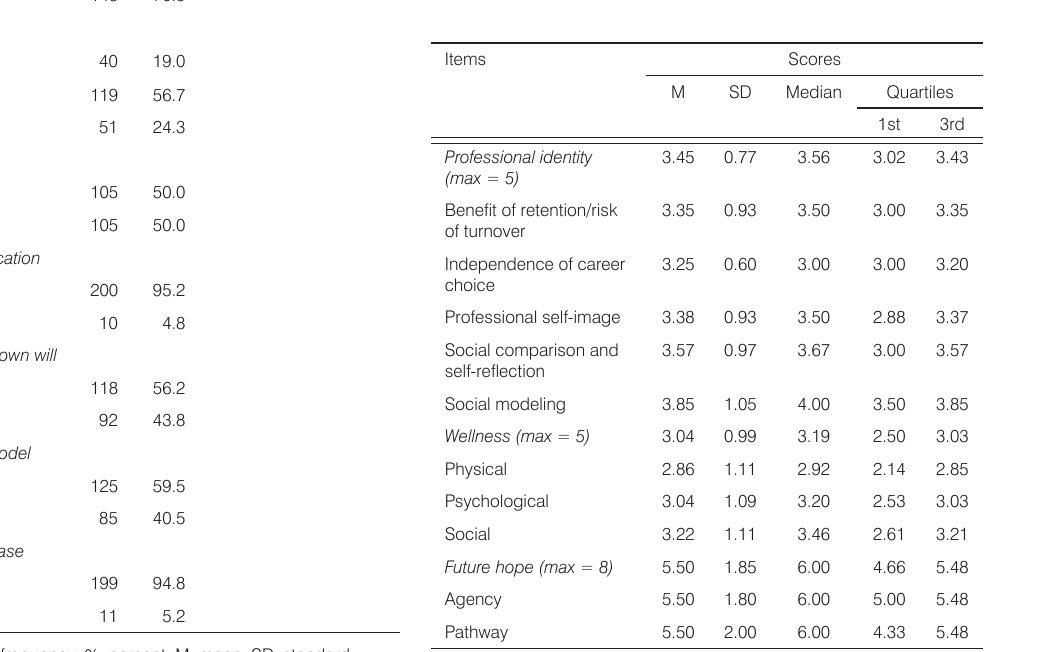
Table 1. Sociodemographic characteristics of nurse interns in the study sample (N = 210).